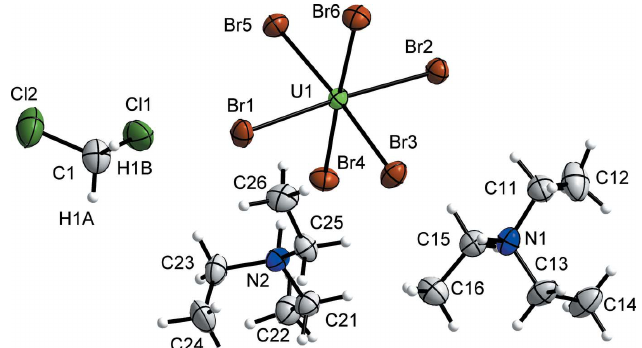
Figure 1 Section of the crystal structure of (Et 3 NH) 2 [UBr 6 ] (cid:2) CH 2 Cl 2 , illustrating the asymmetric unit. Displacement ellipsoids are shown at the 70% probability level at 100 K and H atoms are drawn with an arbitrary